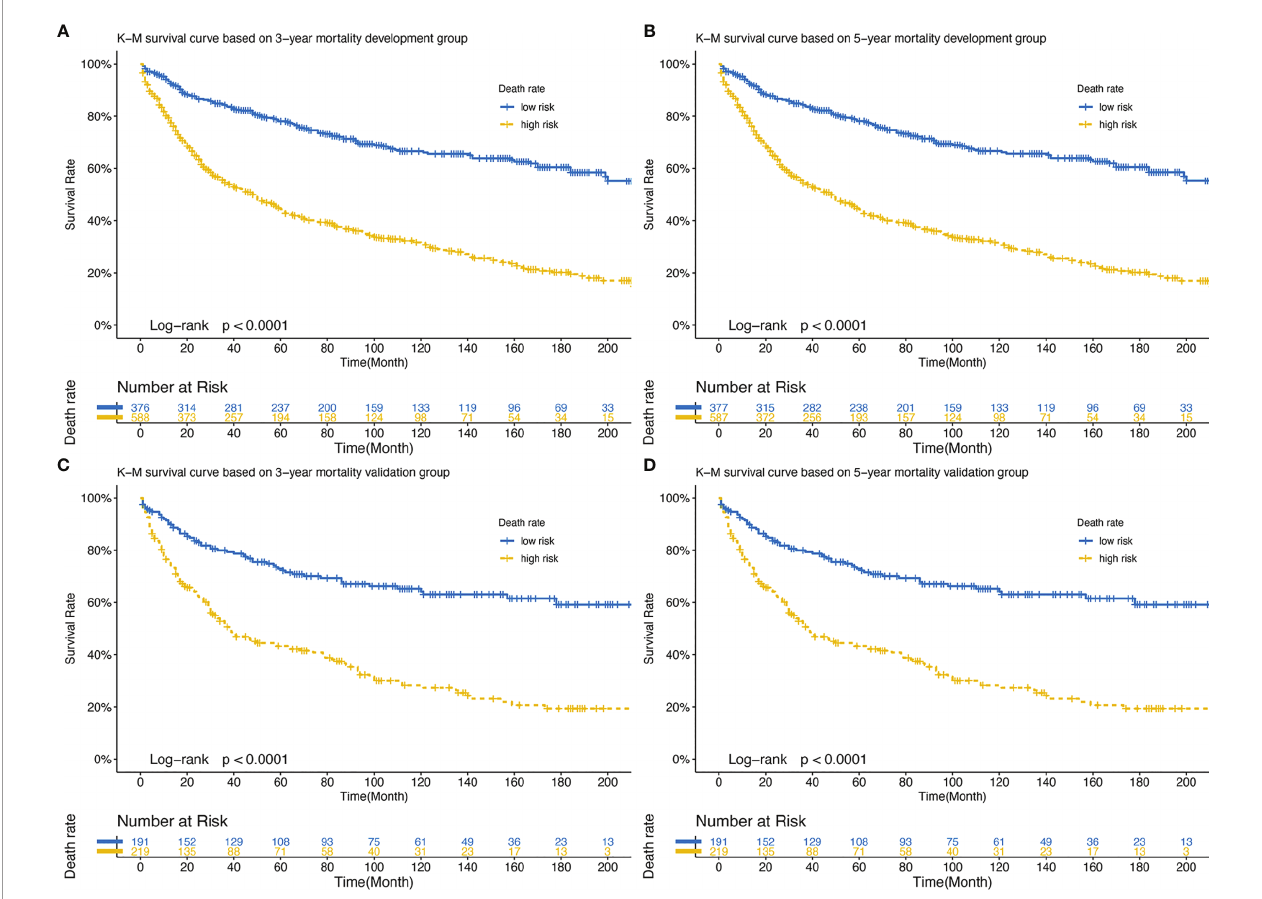
FIGURE 7 | (A) Development set: K-M survival curve based on 3-year mortality; (B) Development set: K-M survival curve based on 5-year mortality; (C) Validation set: K-M survival curve based on 3-year mortality; (D) Validation set: K-M survival curve based on 5-year mortality. K-M,